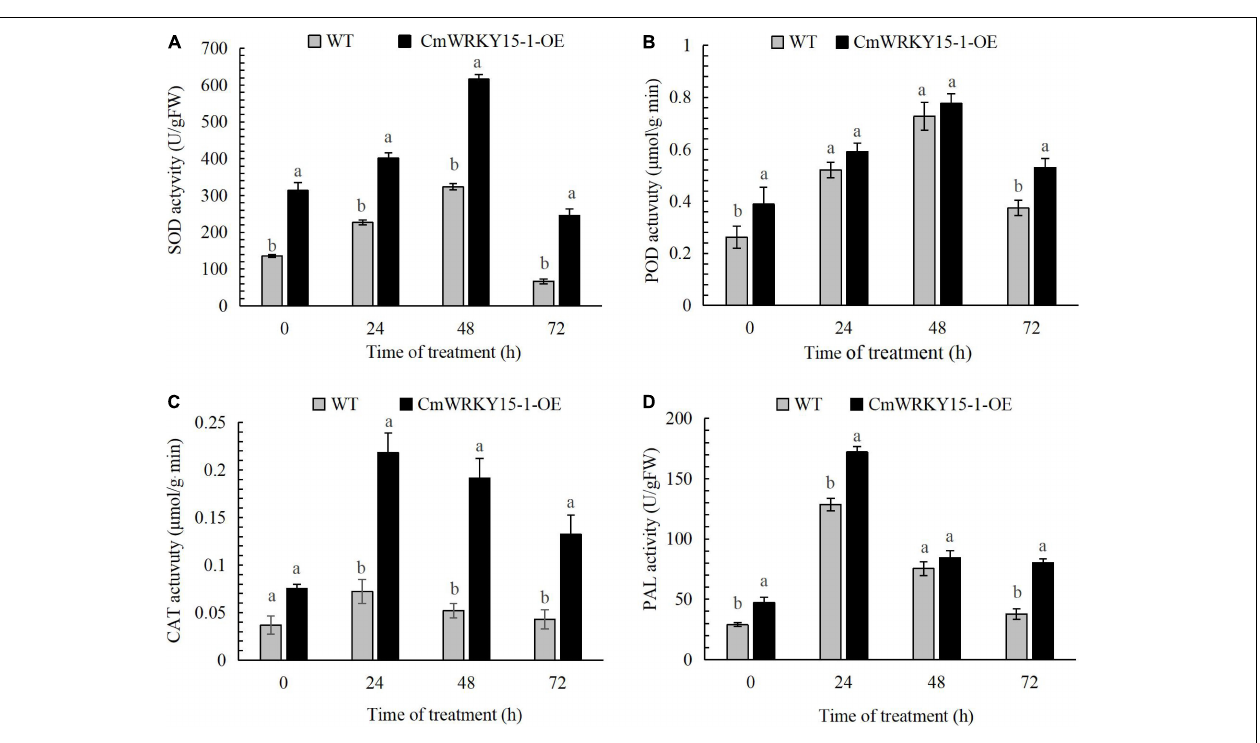
that OE CmWRKY15-1 enhanced plants’ resistance to P. horiana by inhibiting the accumulation of